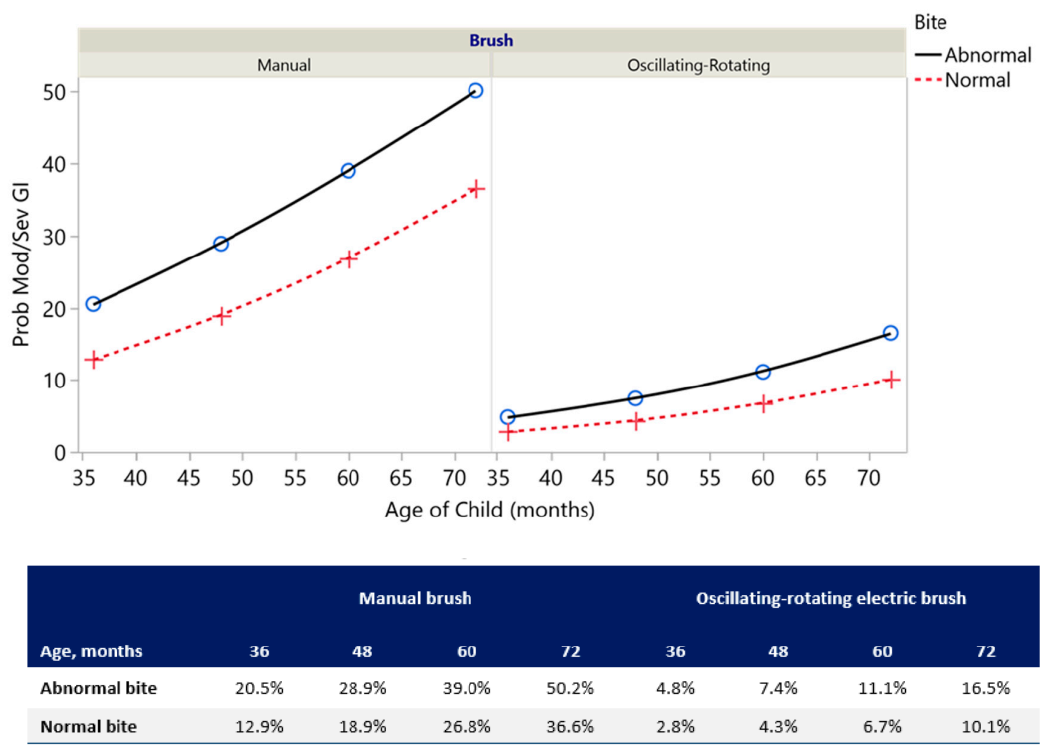
Figure 3. Probability a of moderate / severe gingivitis by Brush Type, Bite Type, and Age (months) from the model in Table